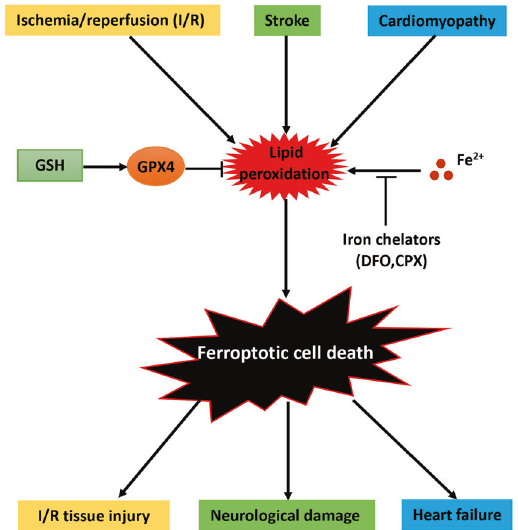
Fig. 4 The role of ferroptosis in I/R injury, stroke and heart failure. Ischemia-reperfusion (IR), stroke, and cardiomyopathy are accom- panied with not only inevitable mitochondrial dysfunction, lipid peroxidation (LPO) and in fl ammation but also ferroptotic cell death, which results in tissue injuries such as ischemia-reperfusion injury, neurological damage, and heart failure that can be ameliorated by inhibition of ferroptosis via increasing GSH levels, GPX activity or iron